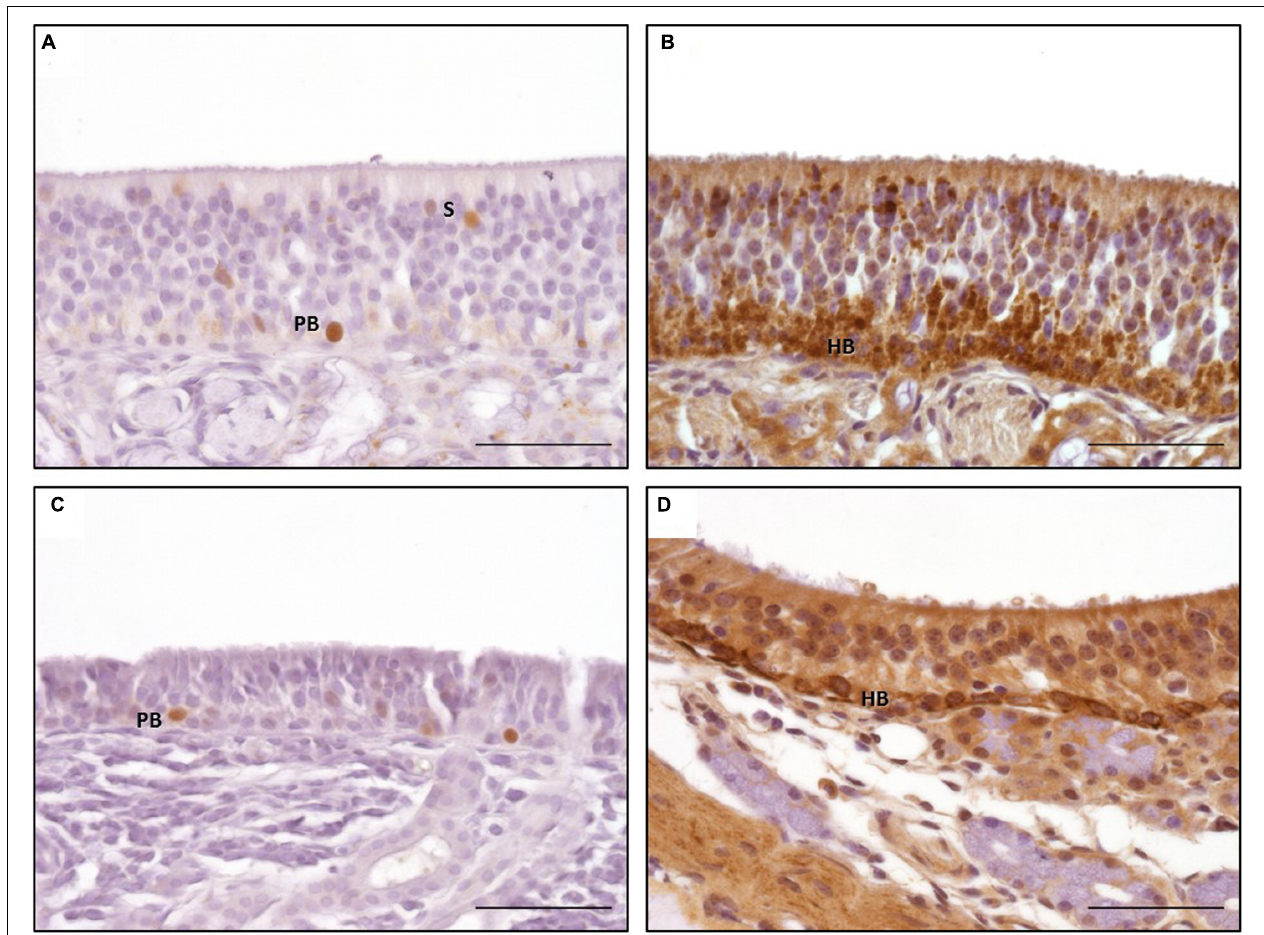
FIGURE 6 | Immunohistological detection of proliferating cell nuclear antigen (PCNA; A,C) and tropomyosin receptor kinase A (TrkA; B,D); a, b: olfactory epithelium type a; (C,D) olfactory epithelium type b; PCNA staining of nuclei of proliferating basal cell in both types of OE (A,C); granular TrkA staining of the horizontal basal cells and sustentacular cells in OE type a (B) and ring-like staining of the plasma membrane of the horizontal basal cells in OE type b (D); PB: proliferating basal cells; HB: horizontal basal cells; scale bar: 50 µ